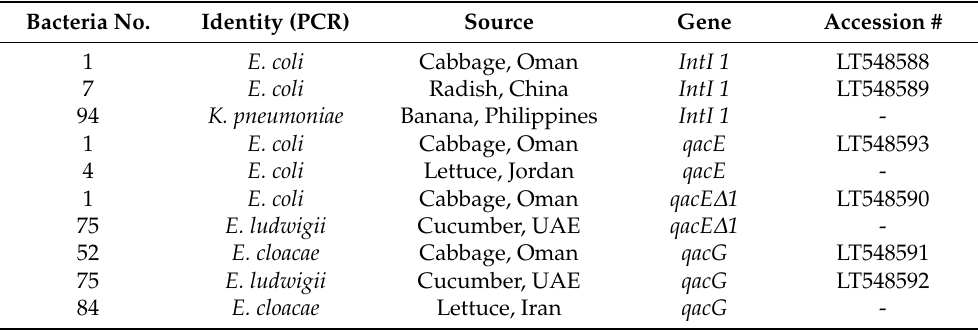
Table 2. Resistance genes of IntI 1 and qac and their accession numbers as given by the European Nucleotide